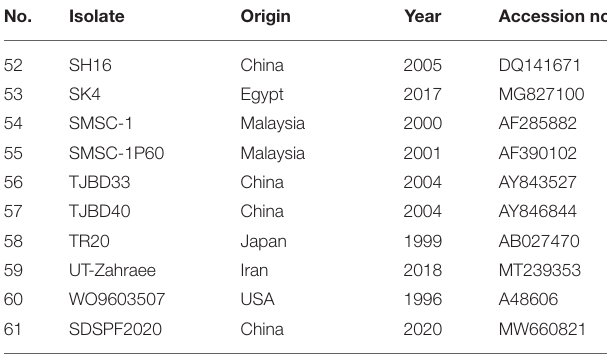
TABLE 1 | The sequence information of CIAV reference strains used in this work. No.